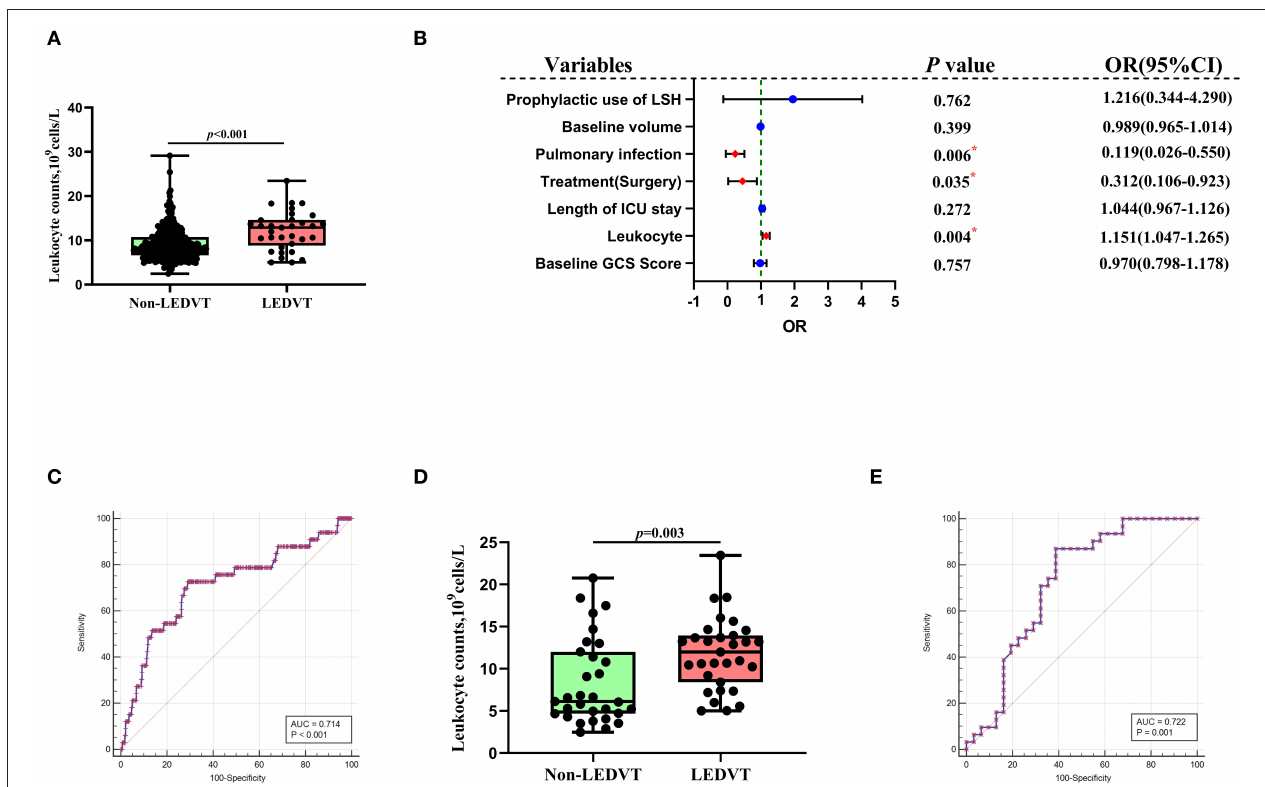
FIGURE 4 | Association of peripheral blood leukocyte counts with LEDVT. (A) Comparison of leukocyte counts between Non-LEDVT and LEDVT groups. (B) Forest plot of multivariate analysis for risk factors associated with LEDVT. (C) Receiver operating curve analysis of leukocyte counts for predicting LEDVT. The optimal cutoff value for leukocyte counts as a predictor for LEDVT in primary intracerebral hemorrhage patients was determined to be 10.22 × 10 9 U/L (AUC was 0.714, the sensitivity was 72.73%, and the specificity was 71.01%). (D) Comparison of leukocyte counts between non-LEDVT and LEDVT groups after propensity-score matching. (E) The area under the curve of leukocytes for LEDVT was 0.722 with a sensitivity of 87.10% and a specificity of 61.29%. A median with the interquartile range was shown for box plots graph in panel A and panel D. Groups were compared using Mann-Whitney U tests. Correlations were determined using Spearman’s correlation analysis (* p < 0.05 ). LEDVT, lower-extremity deep venous thrombosis; LSH, low-dose subcutaneous heparin; OR, Odds ratios; CI, Confidence interval.